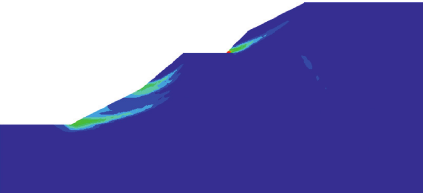
Figure 2: The contour plot of plastic strain magnitude in Abaqus with FS � 1.33.